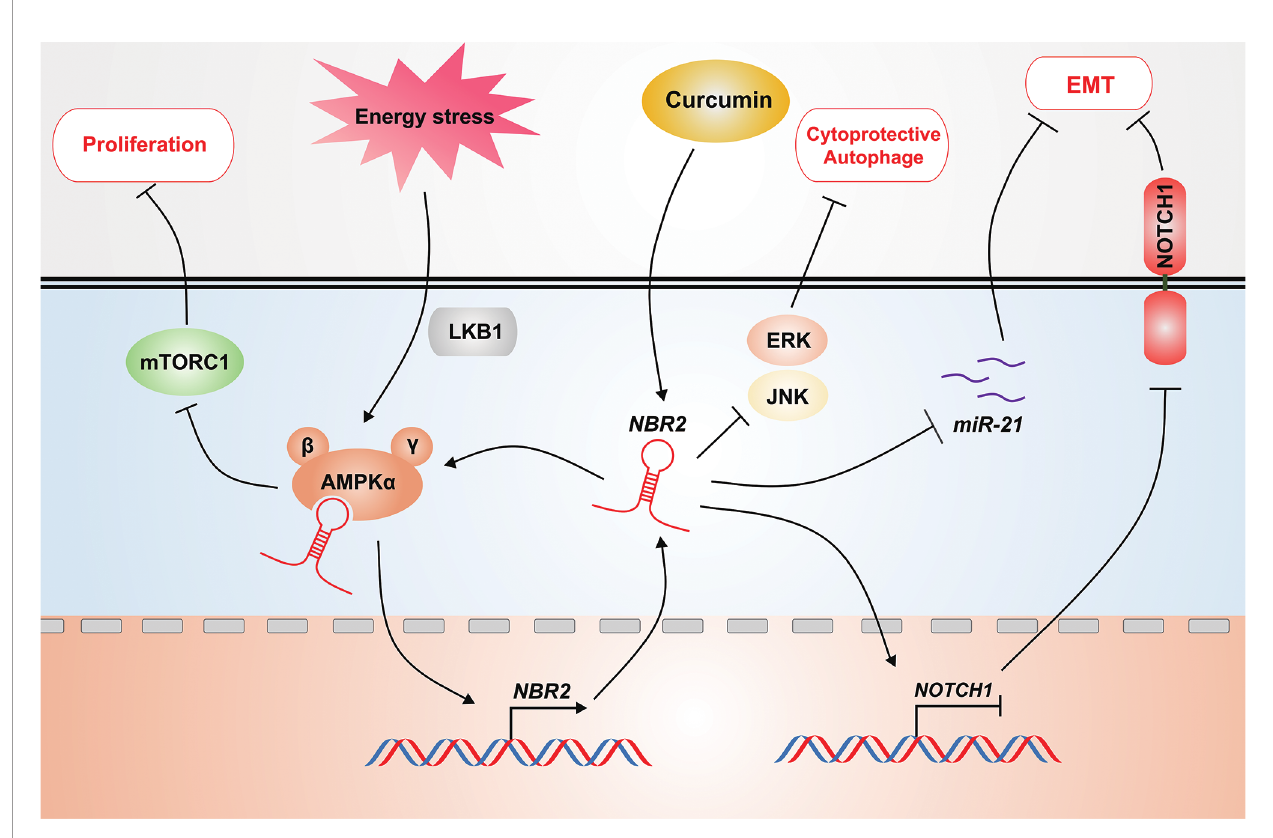
FIGURE 3 | NBR2 functions as a tumor suppressor. NBR2 is responsible for the glucose metabolism in cancer dependent on the AMPK – mTOR pathway. Glucose starvation in TME induces the expression of NBR2 depending on the LKB1 – AMPK pathway. As feedback, stress-induced NBR2 enhances the activity of AMPK kinase by directly interacting with its AMPK a subunit, thereby inhibiting the proliferation of cancer cells. Based on its regulation of the AMPK – mTOR pathway, curcumin-induced NBR2 enhances the antitumor effects of curcumin by suppressing cancer proliferation and clone formation. In addition, NBR2 attenuates EMT by blocking the NOTCH1 pathway and inhibiting miR-21 expression. Moreover, NBR2 impedes Beclin1-induced cytoprotective autophagy, thereby inhibiting cancer proliferation through ERK and JNK